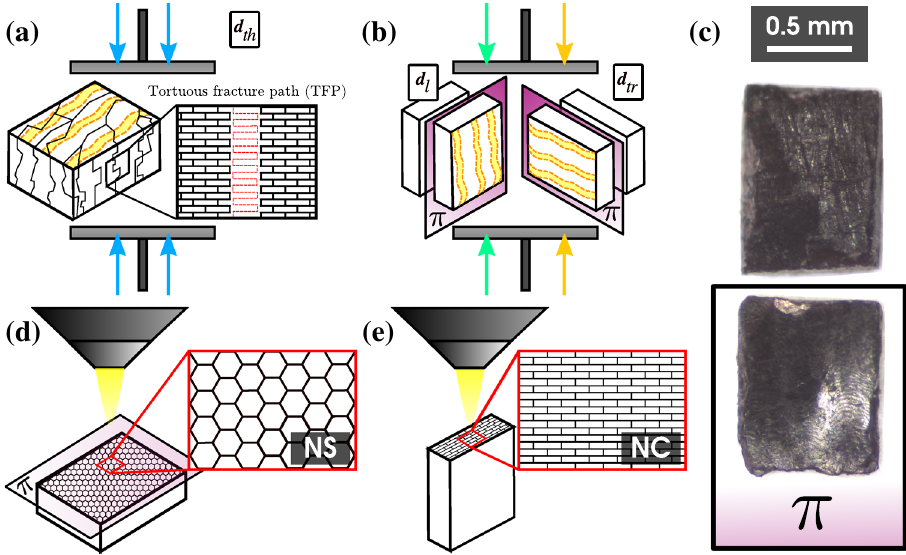
Figure 5. Failure characteristic of the sample at the end of the uniaxial compression test in the thickness ( ddd th ), longitudinal ( ddd l ), and transversal ( ddd tr ) directions. ( a ) fractured sample by failure with an apparently tortuous fracture at the end of the test in the thickness direction ( ddd th ), ( b ) fractured sample by delamination at the end of the compression test in the longitudinal and transversal directions ( ddd l and ddd tr ), ( c ) Photograph of fractured sample after the compression test in the longitudinal and transversal directions ( ddd l and ddd tr ), taken with a stereomicroscope (SMZ-161-BLED; magnification range: 7.5 × − 45 × ) and a microscope camera